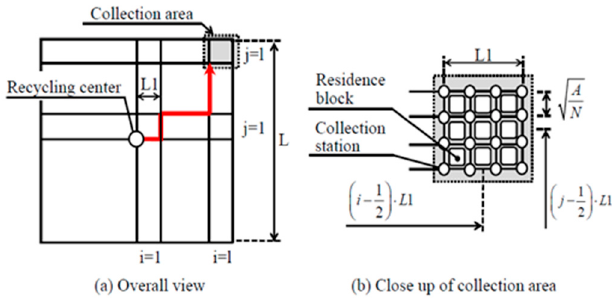
Figure 4. Geometry of grid city model: ( a ) Overall view ; ( b )Close up of collection area